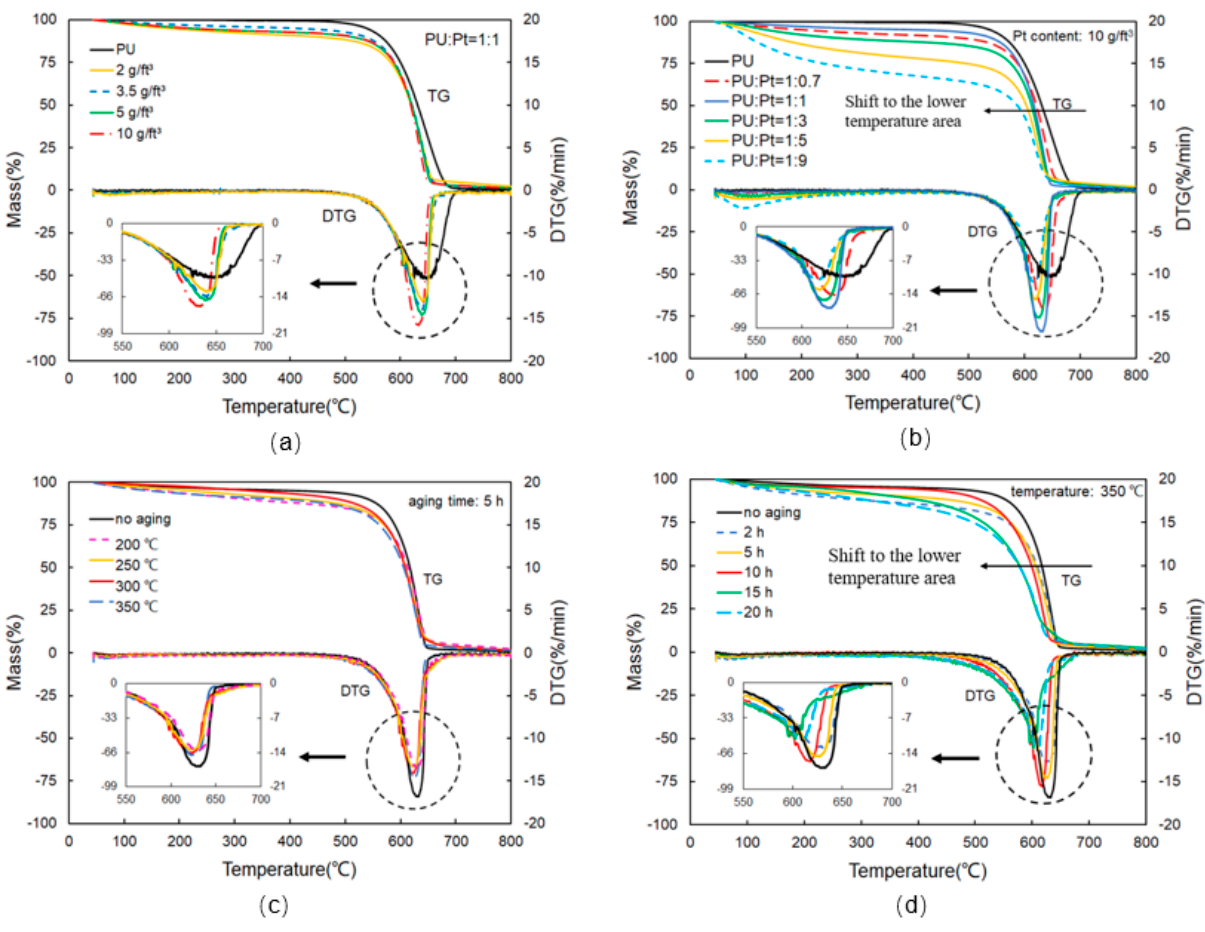
Figure 4. TG-DTG curves in different experiments: ( a ) different Pt contents of PU/catalyst mixtures; ( b ) different ratio of PU/Pt mixtures; ( c ) different thermal aging temperatures; ( d ) different thermal aging times.